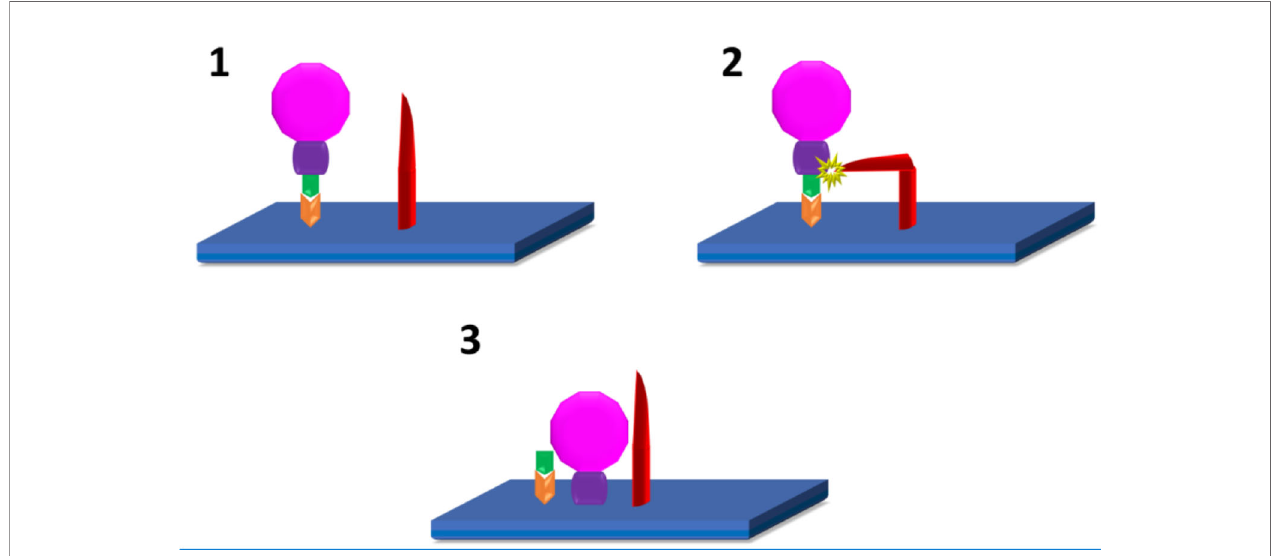
FIGURE 1 | SARS-CoV2 infection of host cells (10 – 12): 1. Attachment of S1(green) subunit of the SARS-CoV-2 (pink) spike protein to the ACE 2 (Orange) receptor on the host cell plasma membrane (blue). 2. Cleavage of S1/S2 (green/purple) complex by either TMPRSS2, or Furin (red) 3. Fusion of the S2 spike protein component with the host cell plasma